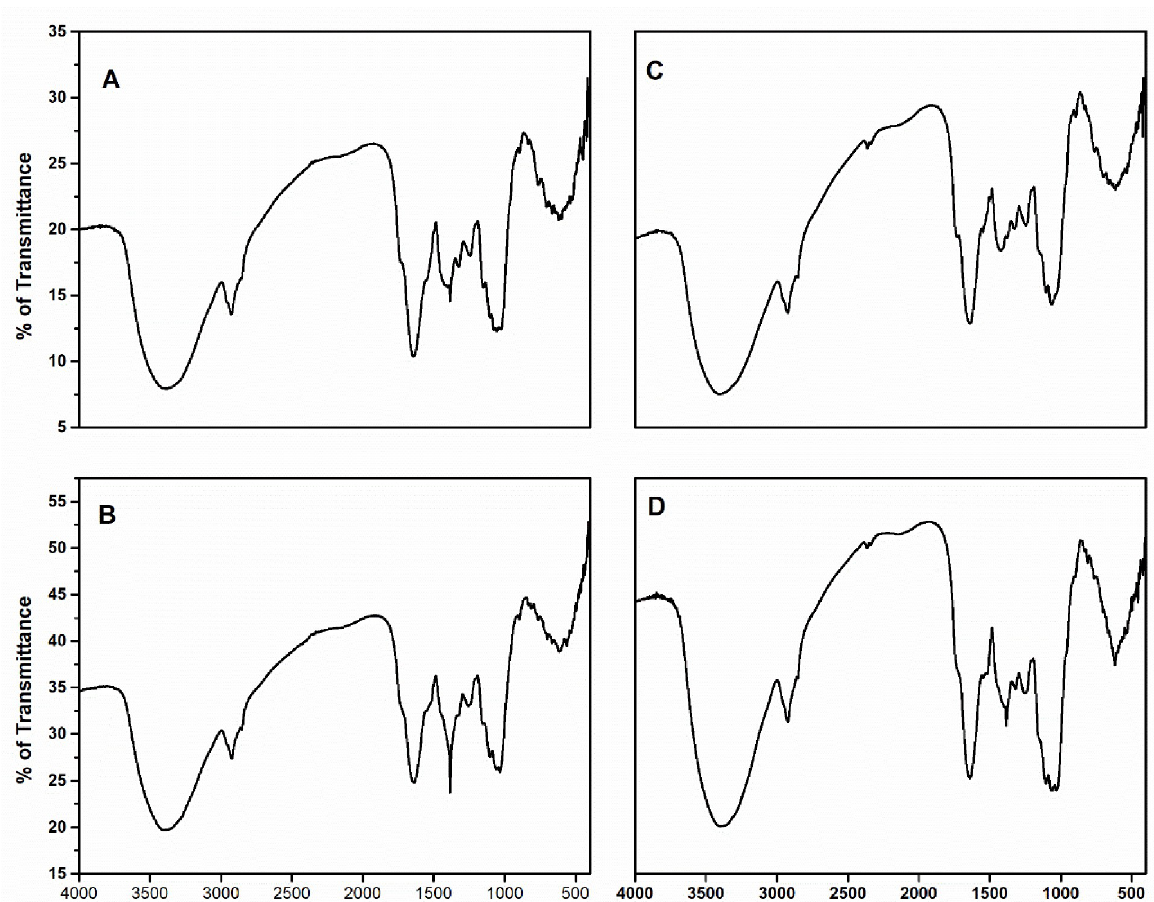
Fig 6. FTIR spectra of control and ZnSO 4 treated plantlets. Control and ZnSO 4 treated leaves (A & B) and Control and ZnSO 4 treated roots